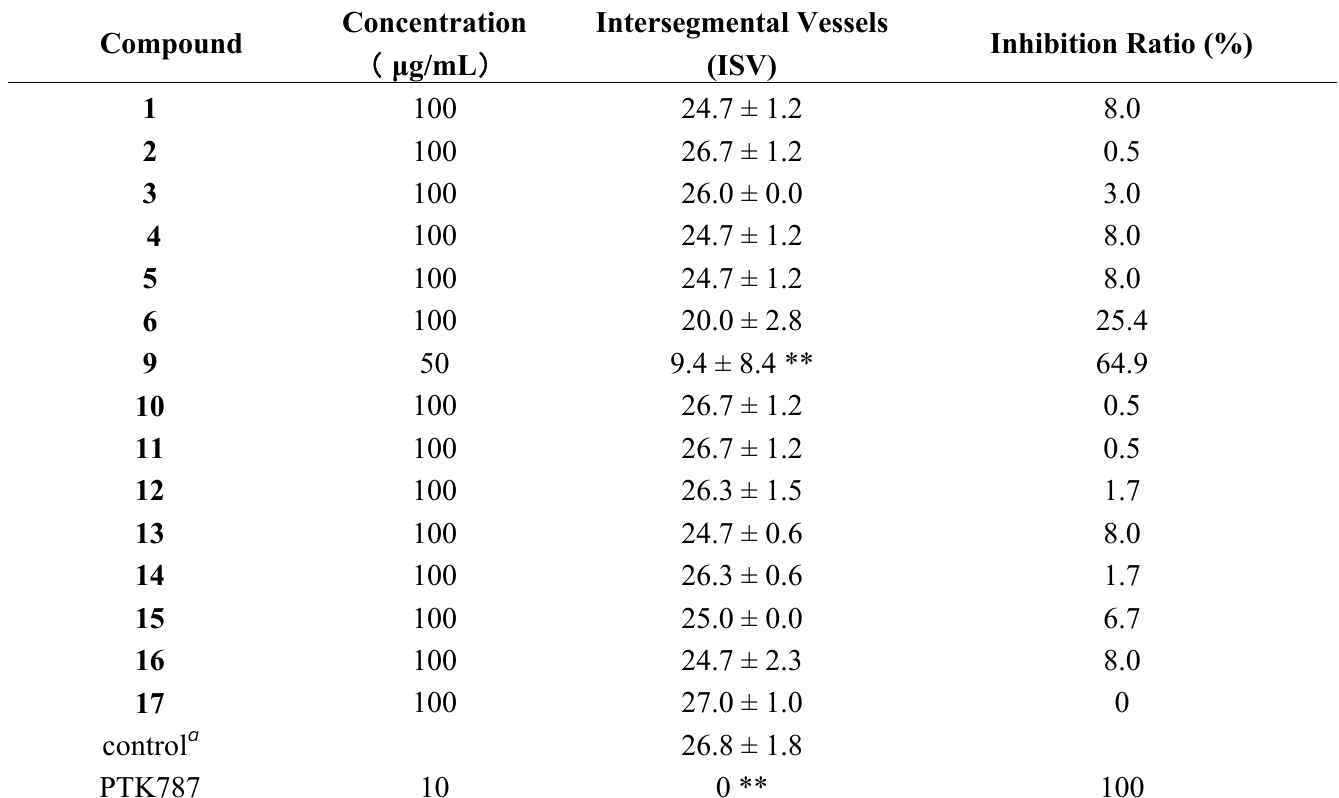
Table 2. Anti-angiogenic activity of compounds 1 - 6 , 9 - 17.